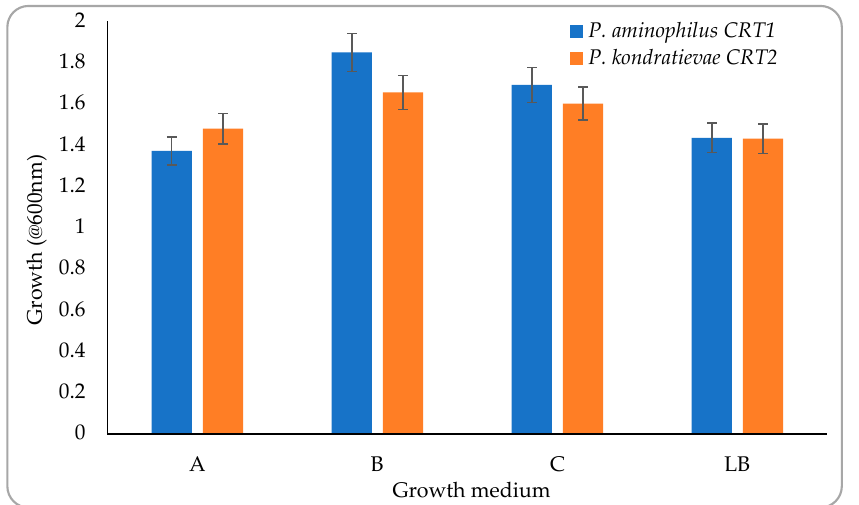
Figure 5. Growth of P. aminophilus CRT1 and P. kondratievae CRT2 in different media, i.e., A (based on NaOH pretreated wheat straw hydrolysate), B (based on NaOH-pretreated sawdust hydrolysate), C (based on microwave-assisted Ca(OH) 2 -pretreated sawdust hydrolysate), and LB medium after 72 h of incubation.